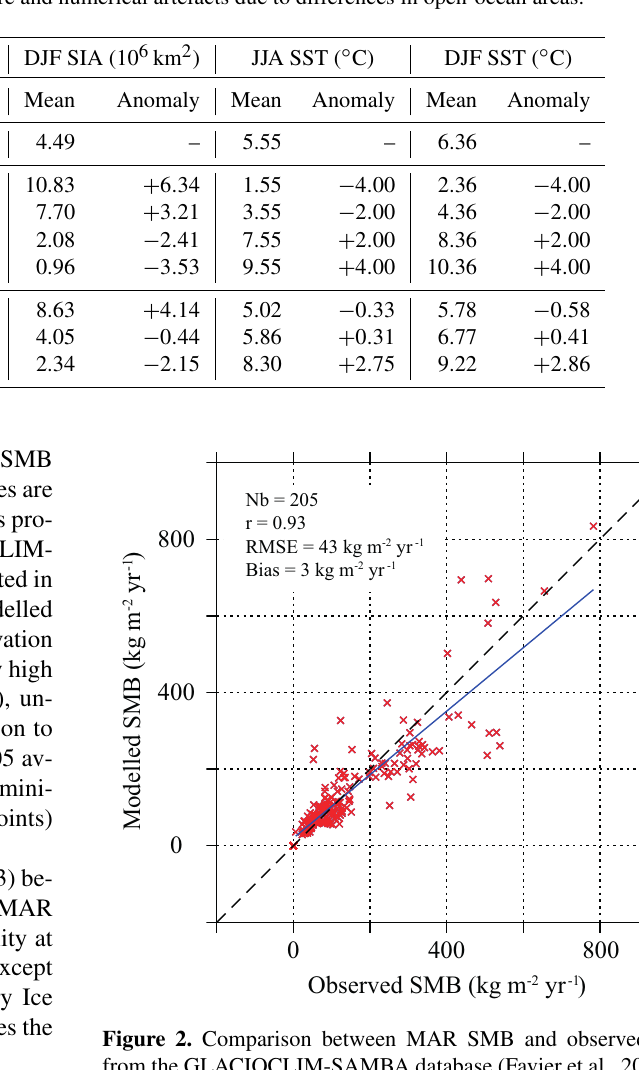
Table 1. JJA and DJF sea ice area (SIA) (10 6 km 2 ) within the MAR domain over the period 1979–2015. SIA is defined as the sum of the products of the SIC and the area of all grid cells with a SIC value of at least 15%. The DJF (JJA) seasonal mean SST is computed for the ocean free of ice in all experiments in DJF (JJA). We only considered grid cells remaining free of ice (SIC < 15%) in all experiments in order to remove the influence of sea ice on surface temperature and numerical artefacts due to differences in open-ocean areas.